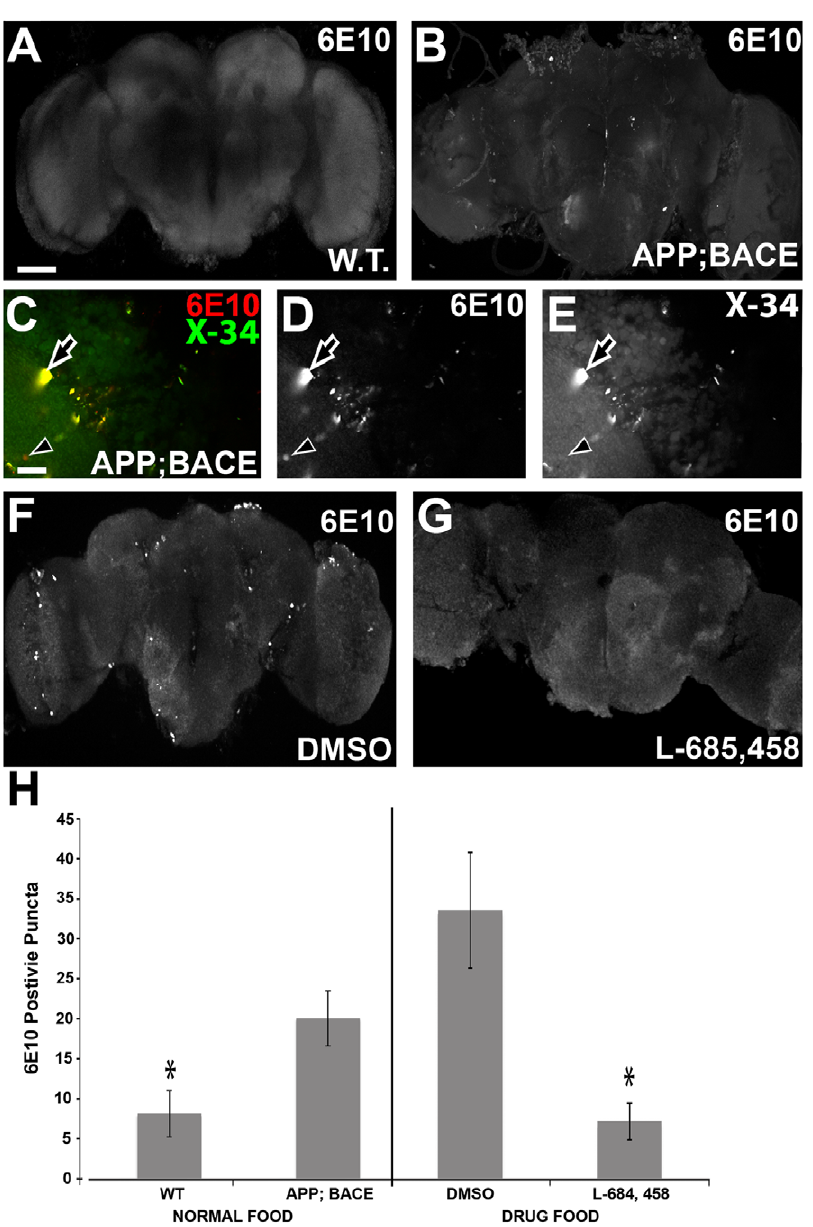
immunoreactive puncta. C ) Co-localization of puncta to 6E10 and X-34 immunoreactivity in elav ; APP ; BACE heterozygous fly brains. High magnification (600 6 ) of 6E10 puncta (red) from cortical area of fly brain show a majority of puncta co-localized with X-34 stain (green). Arrow indicates one example of 6E10 colocalizing with X-34 positive puncta. Arrowhead indicates one example of 6E10 that does not colocalize with X-34 puncta. Scale bar indicates 20 m m for C, D, and E. D ) 6E10 positive puncta (white) from panel C. E ) X-34 positive puncta from panel C. F ) elav ; APP ; BACE heterozygous fly brain six days after eclosion from flies treated with DMSO (vehicle) shows significant 6E10 immunoreactive puncta. G ) elav ; APP ; BACE heterozygous fly brain six days after eclosion from flies treated with L-685,458 ( c -secretase inhibitor) shows minimal 6E10 immunoreactive puncta. H ) Quantification of panels A and B (left) and F and G (right). Error bars represent standard error. * indicates p , 0.05 . n =3–5 fly brains.